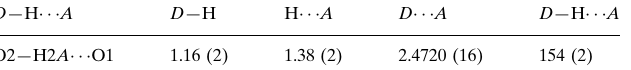
Hydrogen-bond geometry (A˚ , (cid:1)